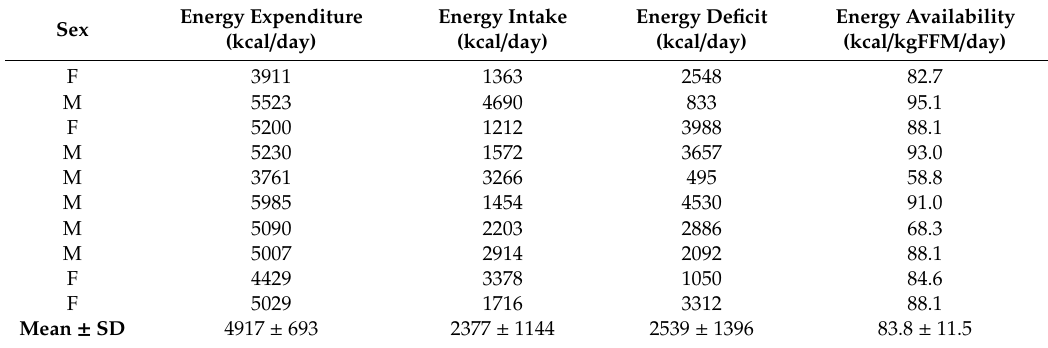
Table 4. Individual total energy expenditure, energy intake, energy deficit and energy availability (n =